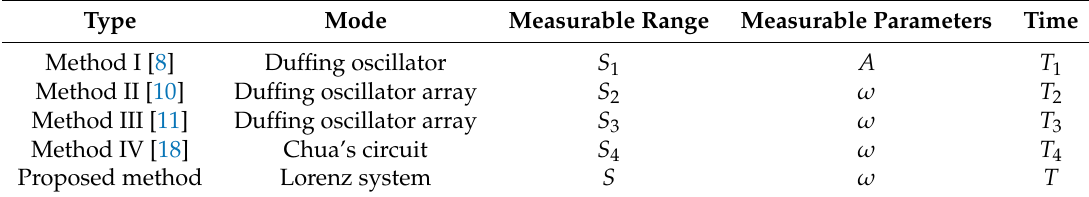
Table 1. Detection methods